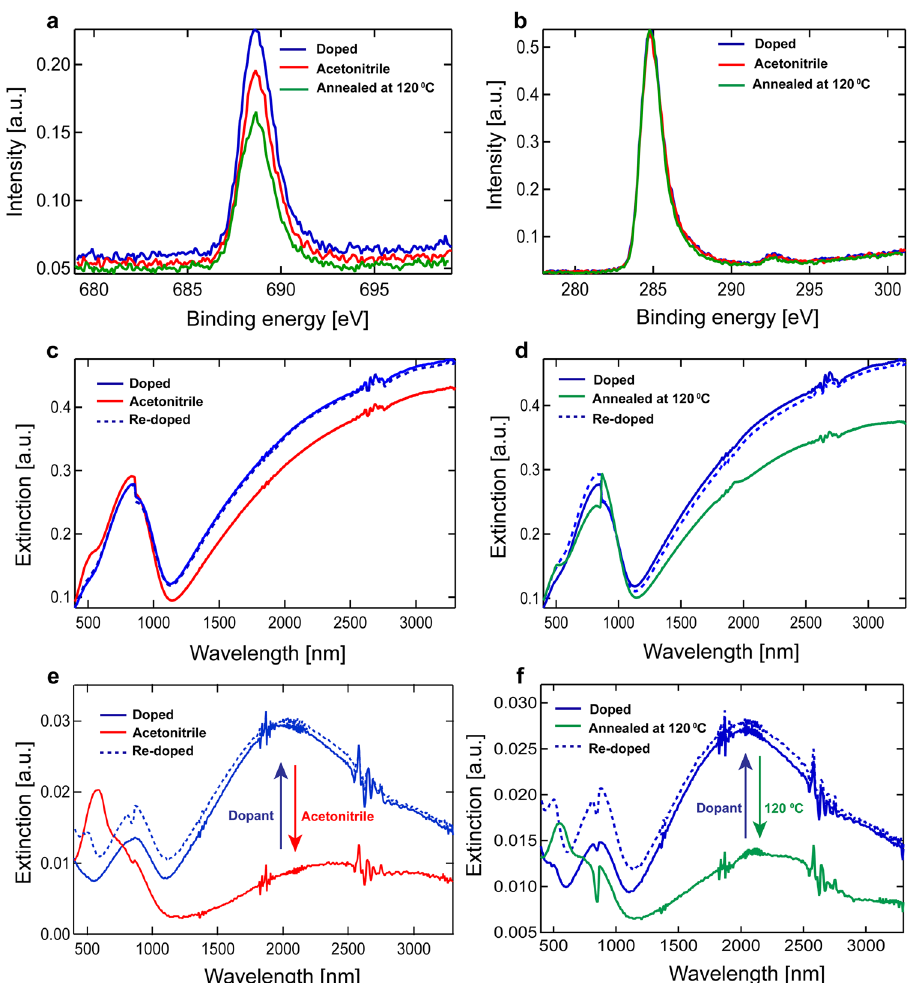
Fig. 3 Reversible switching of PBTTT nanoantennas. a Flourine and b Carbon XPS spectra of PBTTT fi lms after doping, after acetonitrile de-doping, and 120 °C temperature de-doping. The doping levels can be estimated by the F/C atomic composition ratio as summarized in Table S2. The intensities are normalized based on the intensity of the carbon signal. c , d Measured extinction for a thin PBTTT fi lm on glass for ( c ) acetonitrile de-doping and d 120 °C temperature de-doping. e , f Measured extinction for PBTTT nanodisks on glass (thickness = 95 nm, diameter = 394 nm) for e acetonitrile de-doping and f 120 °C temperature